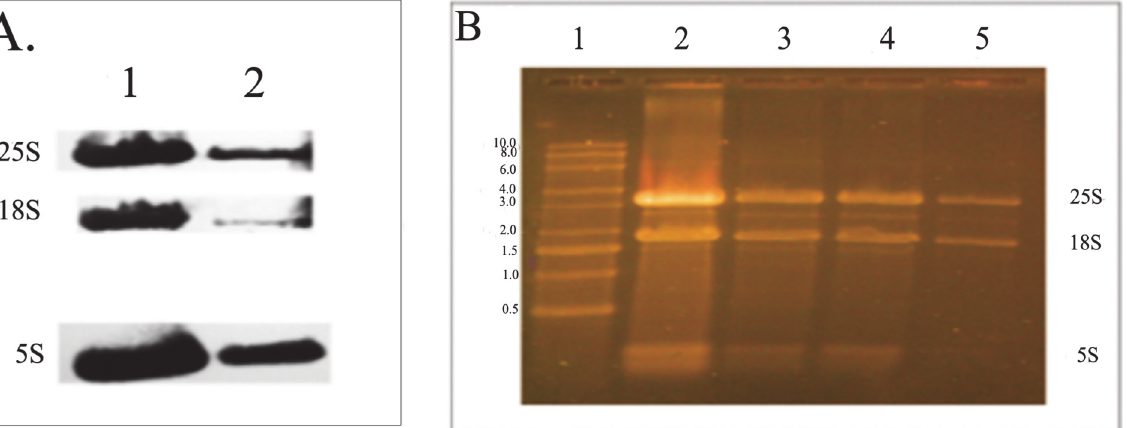
Fig 3. Northern blot analysis for ribosomal RNAs from Candida albicans comparing before and after hyphal stimulation by water with 10% FBS. A. Each lane had 5 μ L loaded from the 50 μ L volume containing the total extracted RNA (see text). Lane 1 was from unstimulated cells (T = 0). Lane 2 from cells exposed to water plus 10% FBS for 30 min (T = 30) at 37°C. Nylon membrane was probed sequentially with probes indicated on Table 1. B. Gel used for blotting seen in part A, stained with SYBR Gold stain. Lane 1 has RNA size markers. RNA loaded for other wells are as follows: Lane 2 – 5 μ L T = 0, Lane